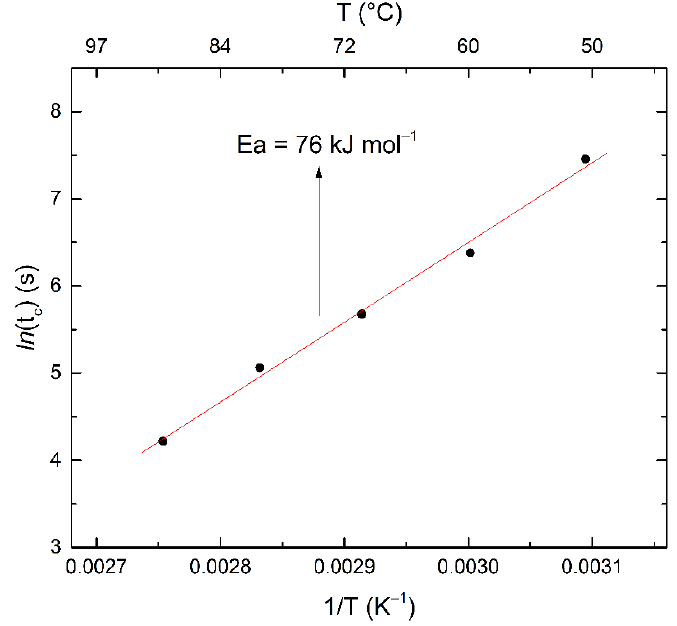
Figure 3. Arrhenius plot of the logarithm of the gelation time vs. reaction temperature according to Equation (5). Hydrogels formed between N- furfuryl chitosan (1 %- w/w ) and PEG(mal) 2 -7500 with R = 0.25. All experimental parameters as specified in Figure 2.